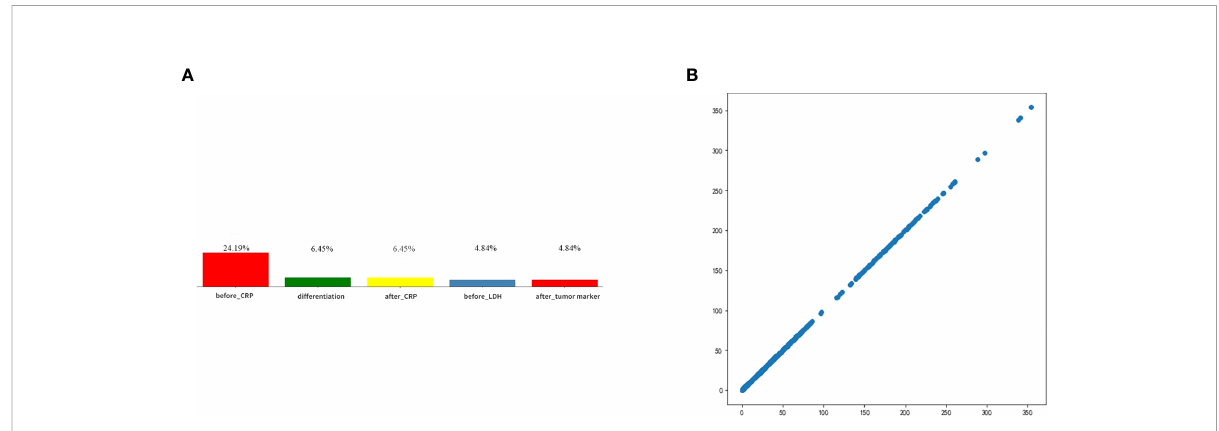
FIGURE 5 (A) Categories of missing values and ratios that need interpolation. (B) The fi t of the imputed data to the original data.